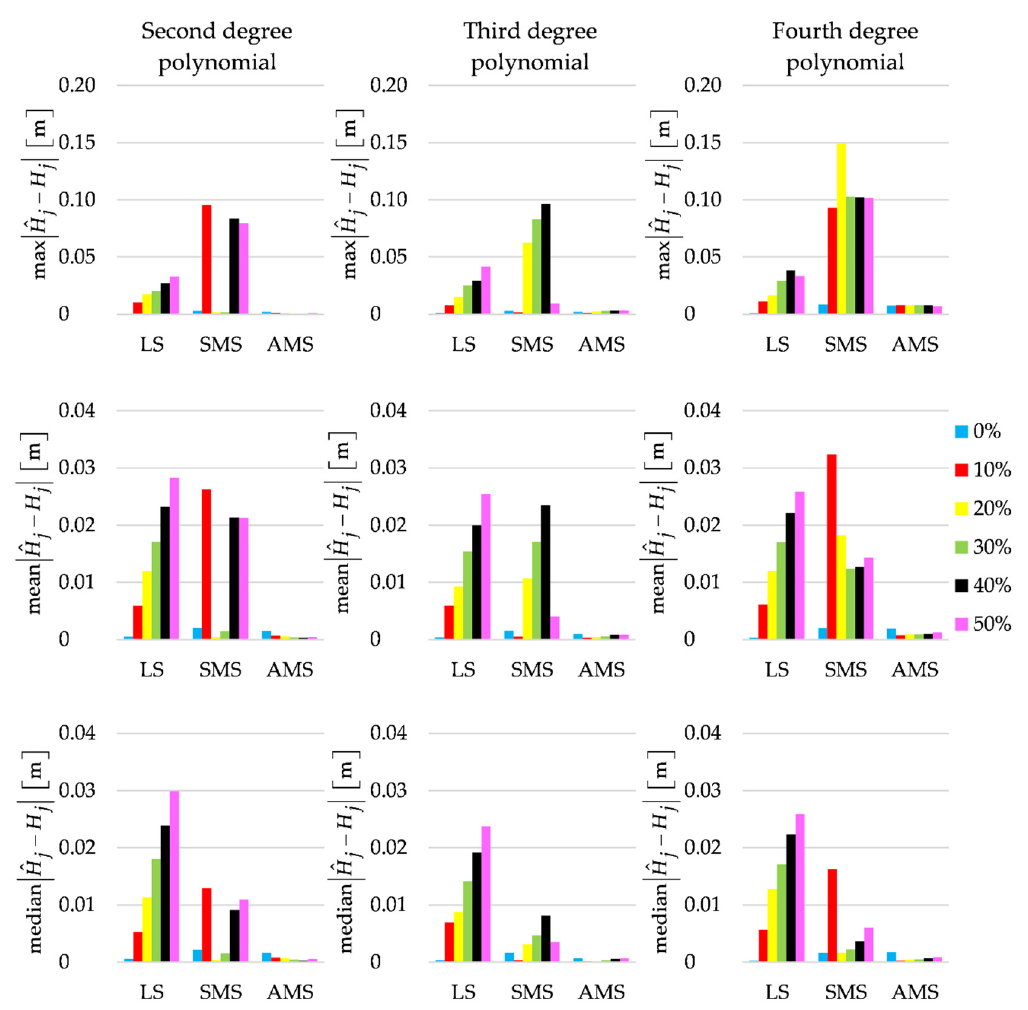
(cid:12) (cid:12) ˆ H − H for LS, SMS and AMS estimates for different percentages of j j